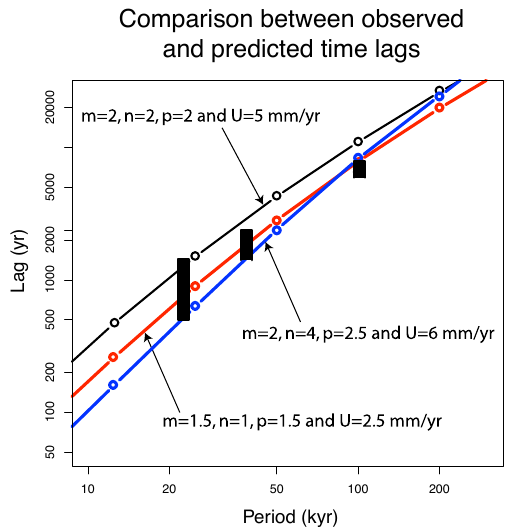
Figure 7. Comparison between observed time lags (i.e., derived from the spectral analysis of the geochemical proxies from Gourlan et al. (2014)) and the model predictions for different values of the m , n and p exponents and the assumed mean (steady-state) imposed uplift rate.